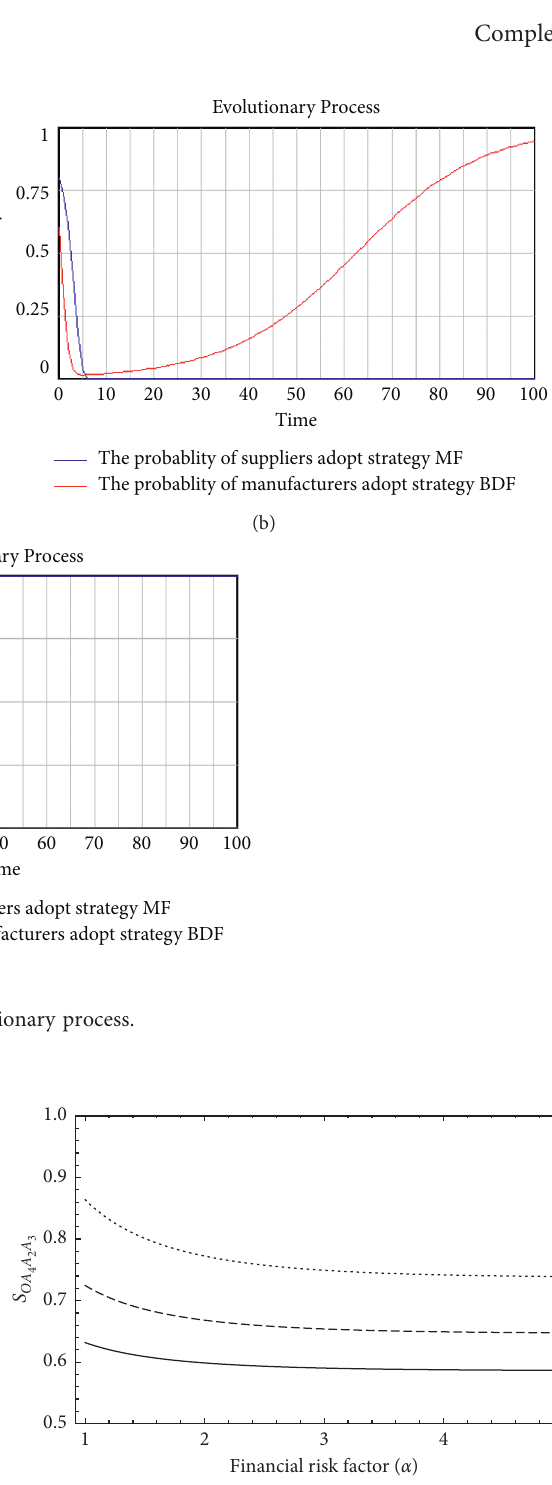
OA 4 A 2 A 3 with